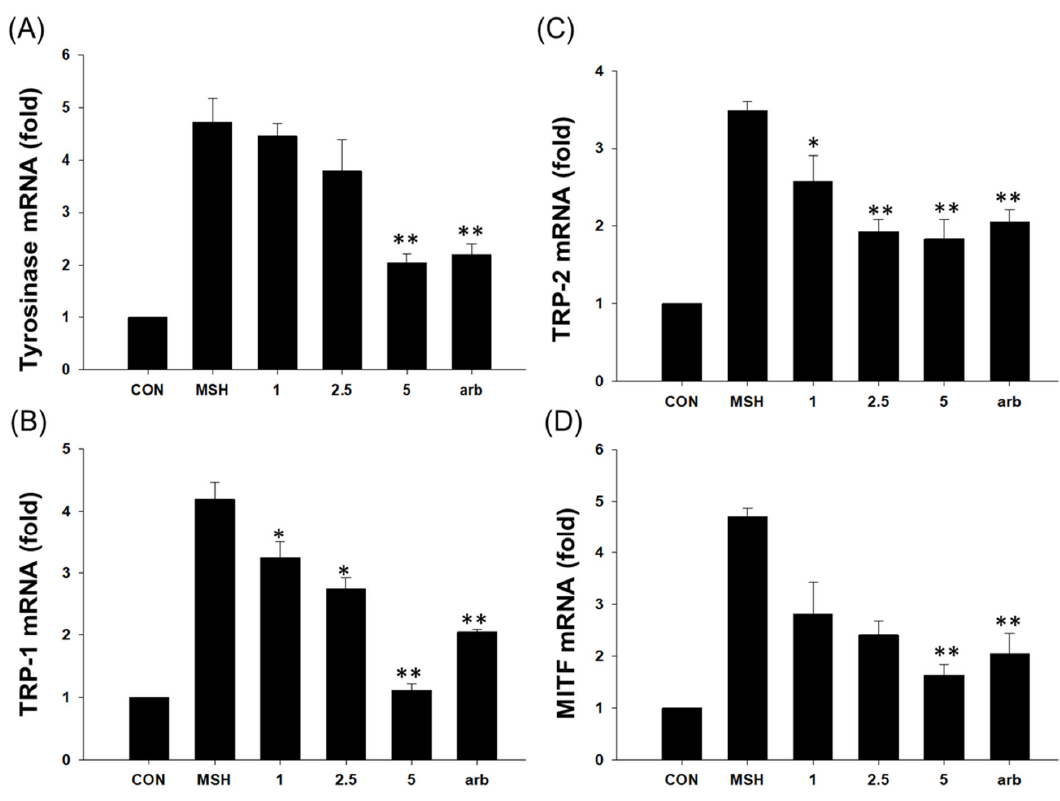
Figure 12. RT-PCR analysis of EG. ( A ) Effects of EG on tyrosinase, ( B ) TRP-1, ( C ) TRP-2, and ( D ) MITF mRNA in B16F10 cells. Data from separate experiments were presented (statistically significant group vs. the vehicle-treated control, * p < 0.05, ** p < 0.01, bars indicate SD). α -MSH: α -melanocyte- stimulating hormone, MITF: microphthalmia ‐ associated transcription factor, TYR: tyrosinase.